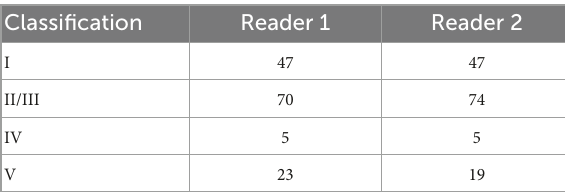
TABLE 2 Classification according to uptake pattern proposed by Reinartz et al.